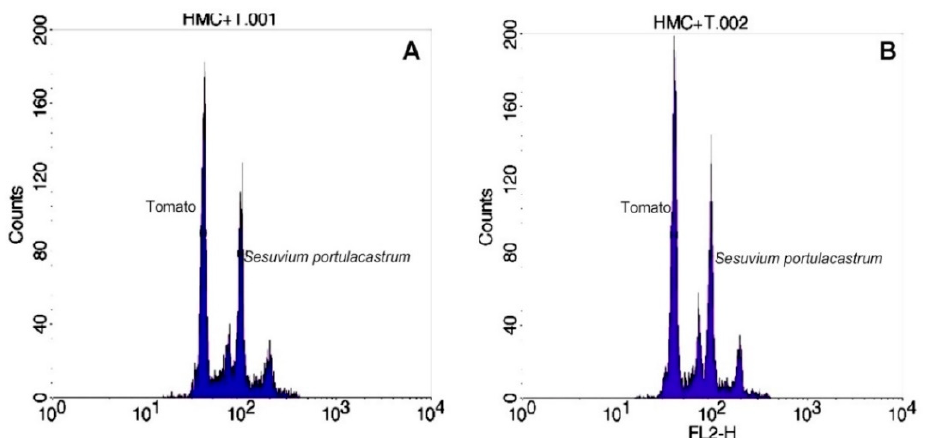
Figure 6. Histograms of relative fluorescence intensity of plants derived from the shoot culture ( A ) and the original S. portulacastrum plants ( B ).